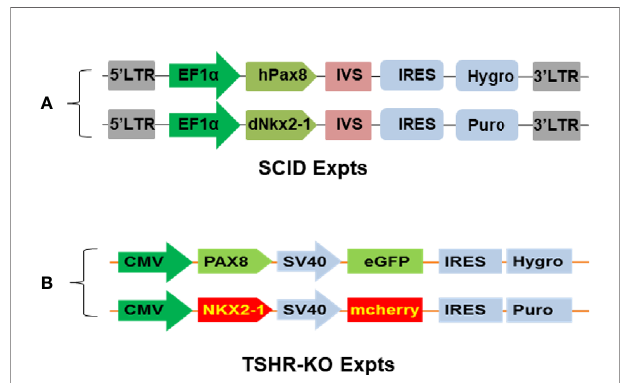
FIGURE 2 | Establishment of syngeneic double positive mouse ES+/- cells. (A, B) represent the bicistronic lent viral vector constructs used for establishing double positive transfected mouse cells expressing Pax8 and Nkx2-1 with and without reporter genes.